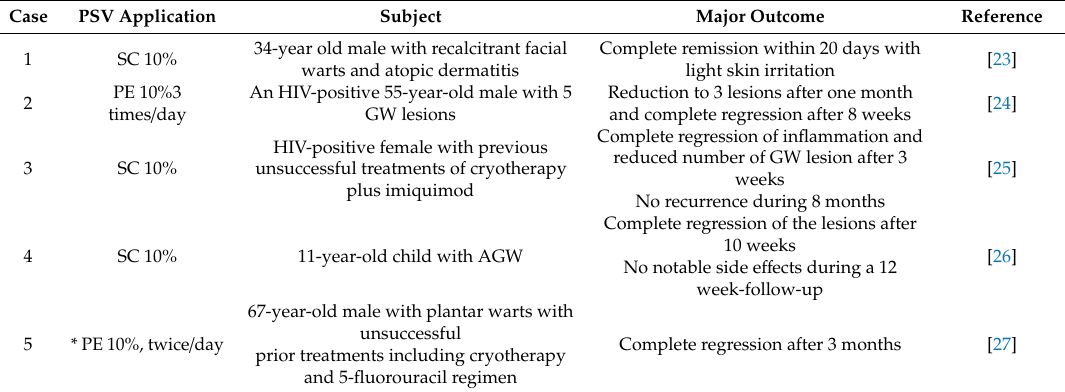
Table 1. Case reports for e ff ects of Polyphenon ® E / sinecatechins / Veregen ® (PSV) on viral